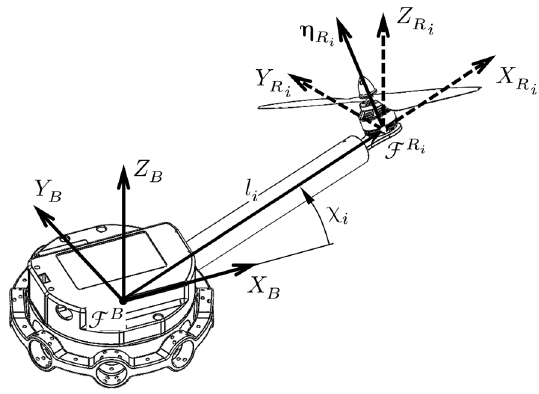
Figure 2. Reference coordinate system of the propulsion system i -th rotor.